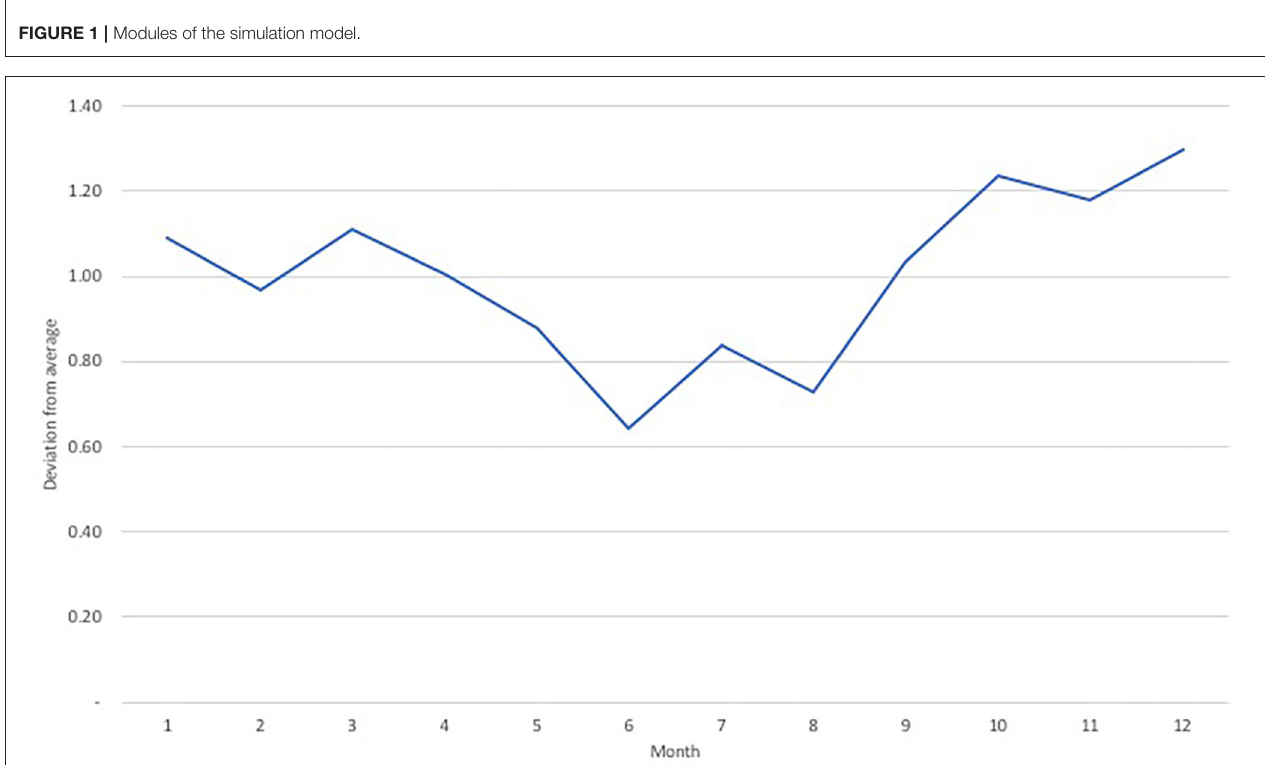
FIGURE 2 | Average seasonality of animal offtakes from Burkina Faso to Ghana, 2014–2018. Ouedraogo (8).